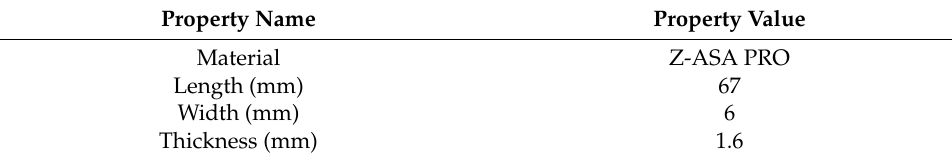
Table 6. Specification of the specimen.